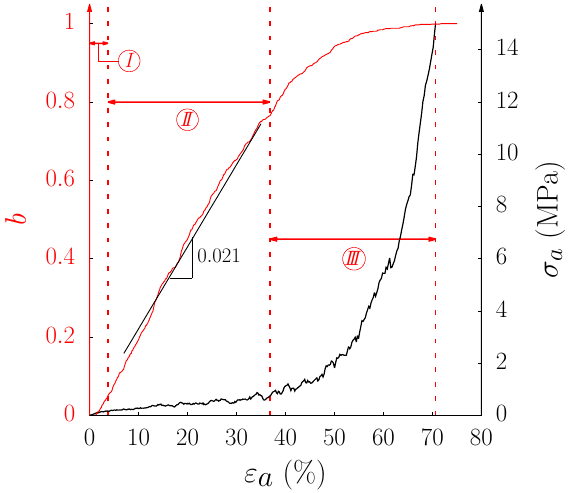
Figure 3. Evolution of breakage ratio b (red curve and left- side axis) in three distinctive zones I behaviour (black curve and right-side axis).